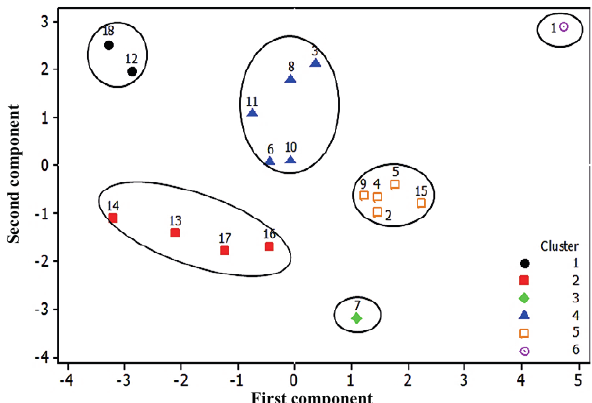
Figure 5. Diagram resulting from principal components analysis (PCA) of Ferula assa-foetida L . populations.